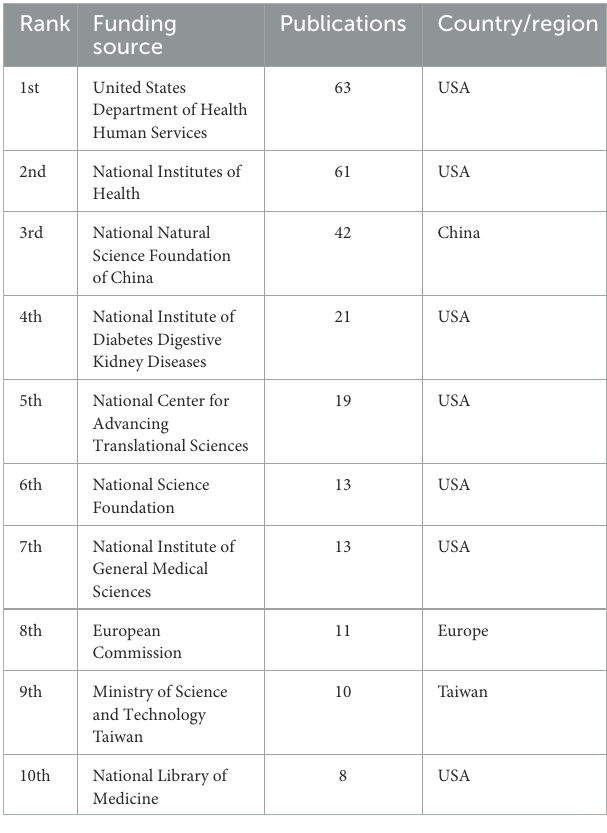
TABLE 6 Top 10 funding sources by